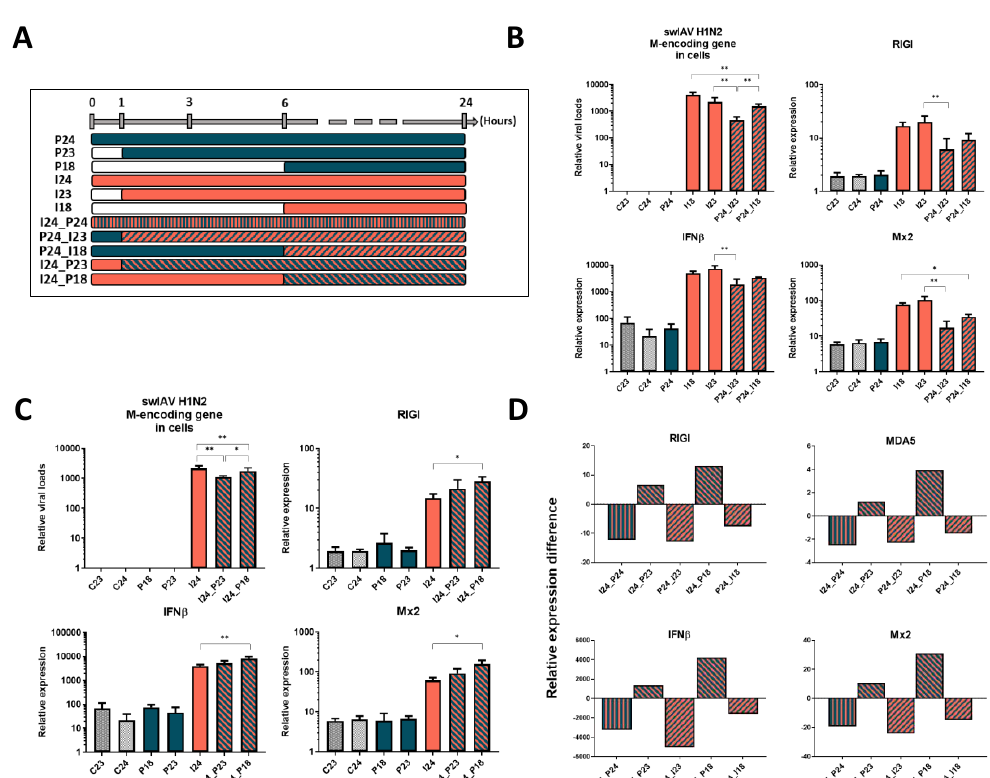
Figure 2. Protocol ( A ) and relative expression of viral and cellular transcripts ( B , C ) of the di ff erent conditions in newborn pig tracheal cells showing the impact of the delay and the order of the viruses on swIAV H1N2 replication and NPTr cells response. Di ff erence of the relative expression between dual stimulations and influenza single infections is represented in panel ( D ). Cells were infected at a MOI of 3, n = 6 wells per condition for qPCR. C23 and C24 stand for the non-infected conditions over 23 h and 24 h respectively, P24 stands for PRRSV-1 stimulation over 24 h, I24 for swIAV H1N2 infection over 24 h, I24_P24, P24_I23, P24_I18 stand for dual administrations (PRRSV-1 then swIAV) of both viruses with a delay of 0, 1, and 6 h respectively. I24_P23 and I24_P18 stand for dual administration after reversing the viruses (swIAV then PRRSV-1) order with a delay of 1 and 6 h respectively. Mean values and standard deviations are represented. Comparisons were carried out using a one-way ANOVA test and Tukey’s post-test after sorting the data by rank. Di ff erences were considered significant when p < 0.05 (*) or p < 0.01